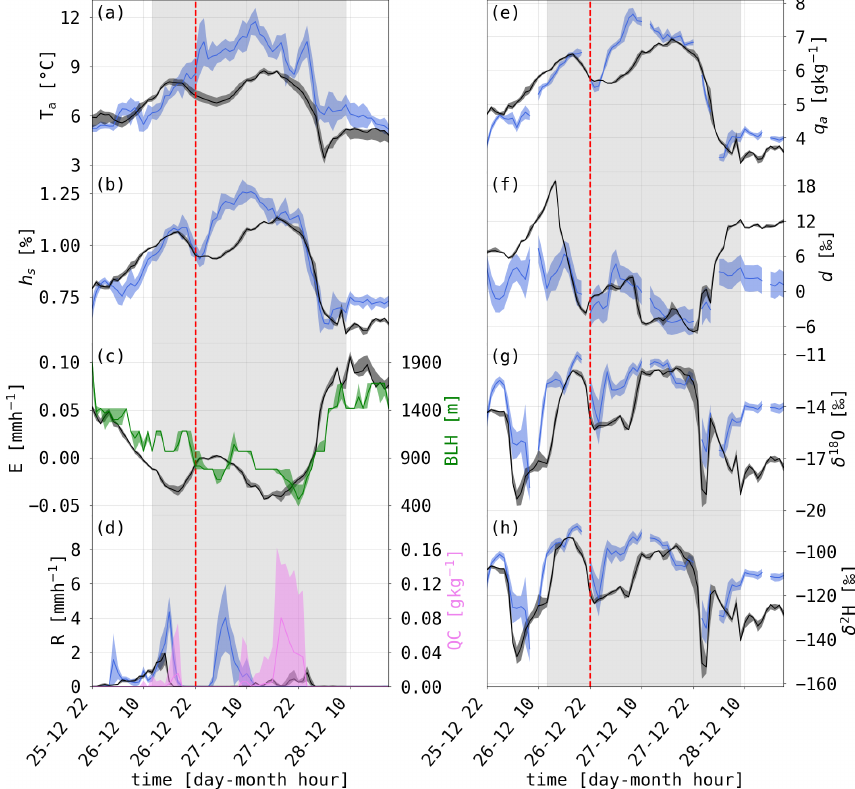
Figure 6. Time evolution of hourly (a) air temperature T a , (b) h s , (c) ocean evaporation E (positive upward) and boundary layer height BLH (green), (d) precipitation rate R and mean cloud water content on the five lowest model levels (10–200ma.s.l.) (QC), (e) specific humidity ( q a ), (f) d , (g) δ 18 O, and (h) δ 2 H from ACE measurements and COSMO iso simulations interpolated along the ship track during the warm temperature advection event at Marion Island from 26 to 28 December 2016. The blue lines show the measurements with hourly standard deviation; the black, green and pink lines show the simulated values including the variability from 10 ◦ latitudinal and longitudinal shifts of the ACE track (black, green and pink areas). The vertical red dashed line denotes 22:00UTC on 26 December 2016. The shaded grey areas correspond the time period of the warm temperature advection